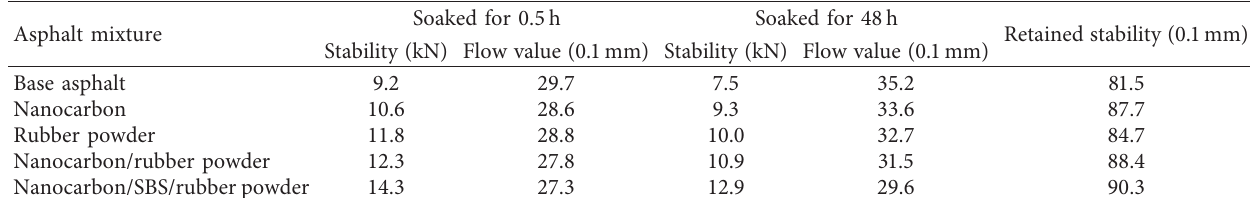
Table 10: Results of the immersion Marshall